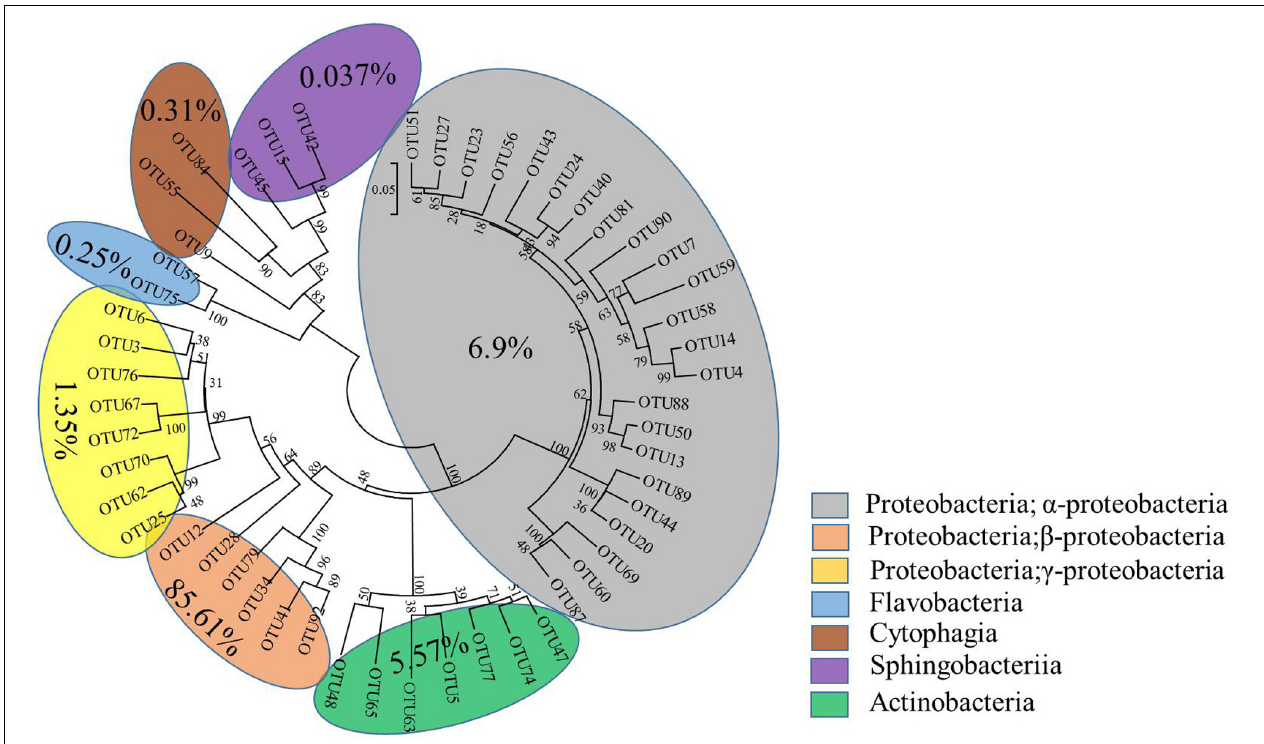
FIGURE 5 | Phylogenetic tree based on the HTS of the acetamiprid-degrading consortium ACE-3. The scale bar indicates 0.05 substitutions per nucleotide position.